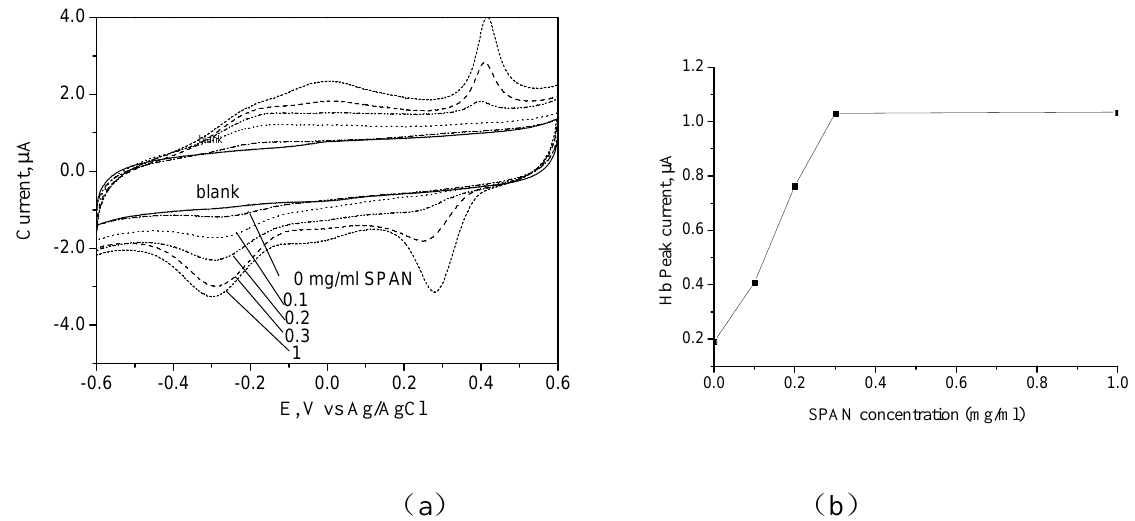
Figure 2. (a) Influence of concentration of SPAN on CV response of Hb (the concentration of Hb was 1 mg/mL). The inner blank curve stands for CV in the absence of Hb. (b) The peak current of Hb increased with increasing SPAN